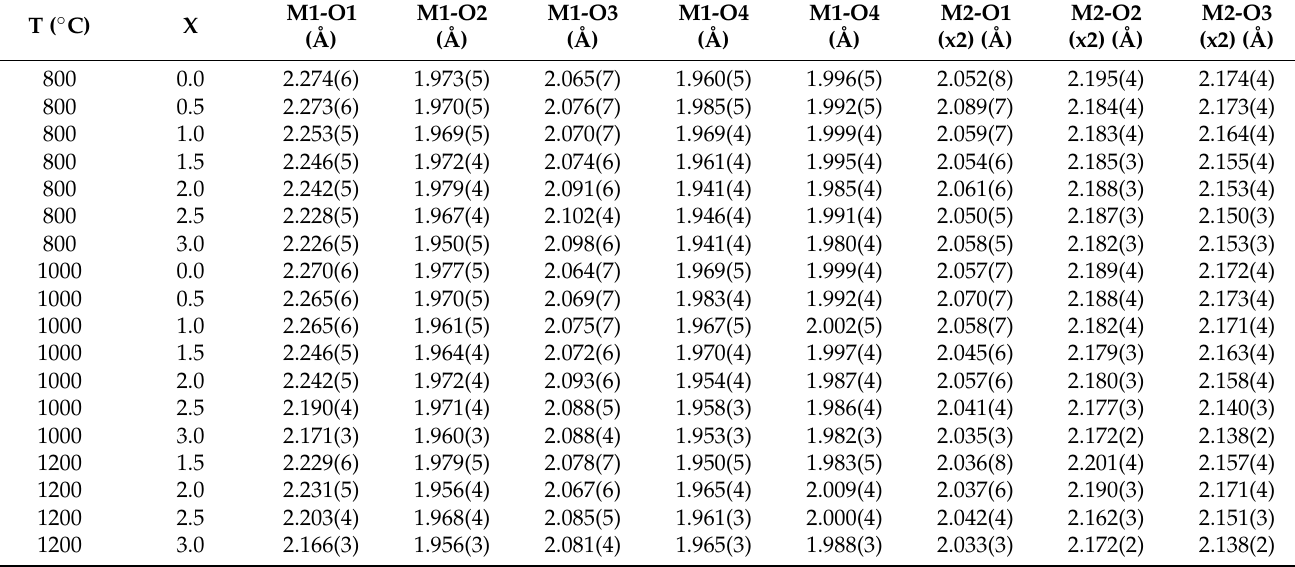
Table 3. Variations in the M-O (M = Co, Mg) distances in the stable Co 3 P 2 O 8 structure with tempera- ture in the Mg x Co 3 − x P 2 O 8